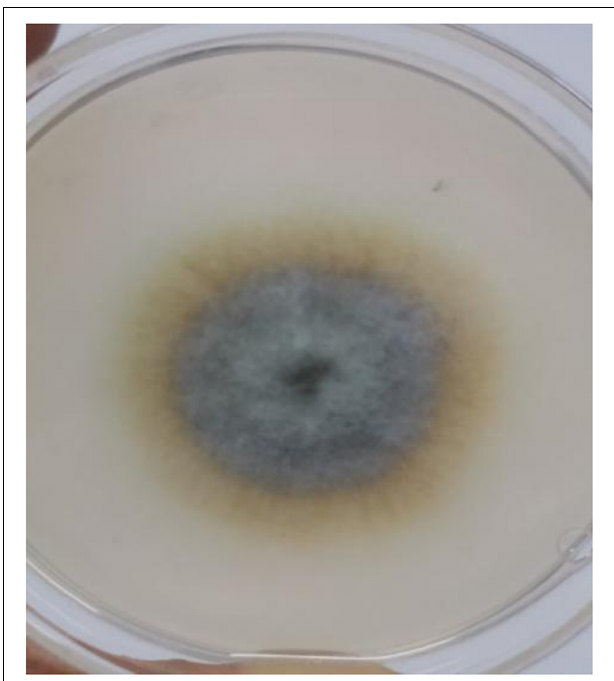
FIGURE 1 | Morphological characteristics of cadmium and antimony tolerant fungi.